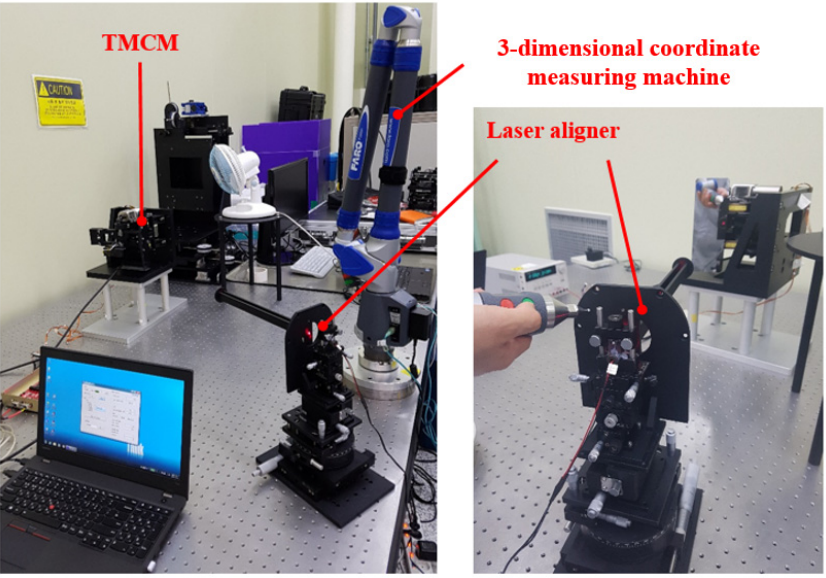
Figure 6. Operational function test set ‐ up of TMCM.